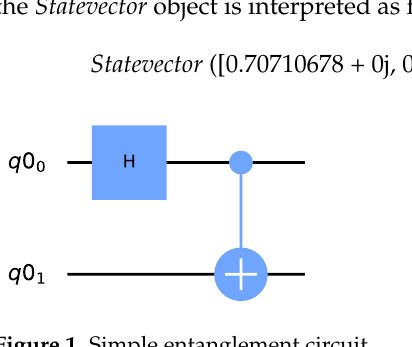
Figure 1. Simple entanglement circuit.